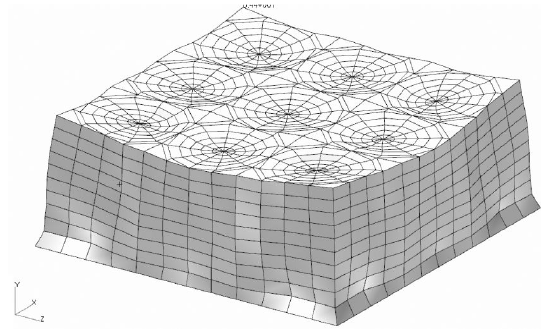
Fig. 33. 11th mode: 1471 Hz – First axial mode (1687 Hz – Quad-cell).